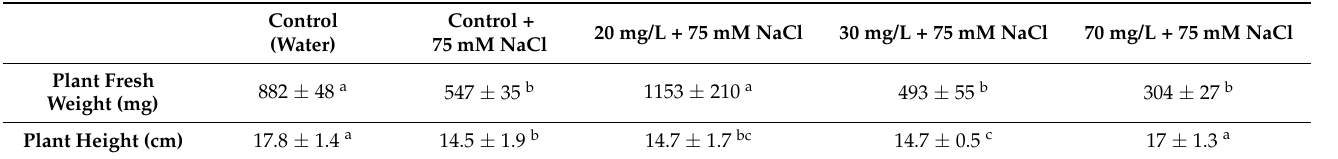
Table 1. The effects of C. oxyacantha extract on the traits of tomato seedlings affected by salt stress. Different letters indicate significant differences between conditions ( p < 0.05) within conditions according to Tukey’s multiple range